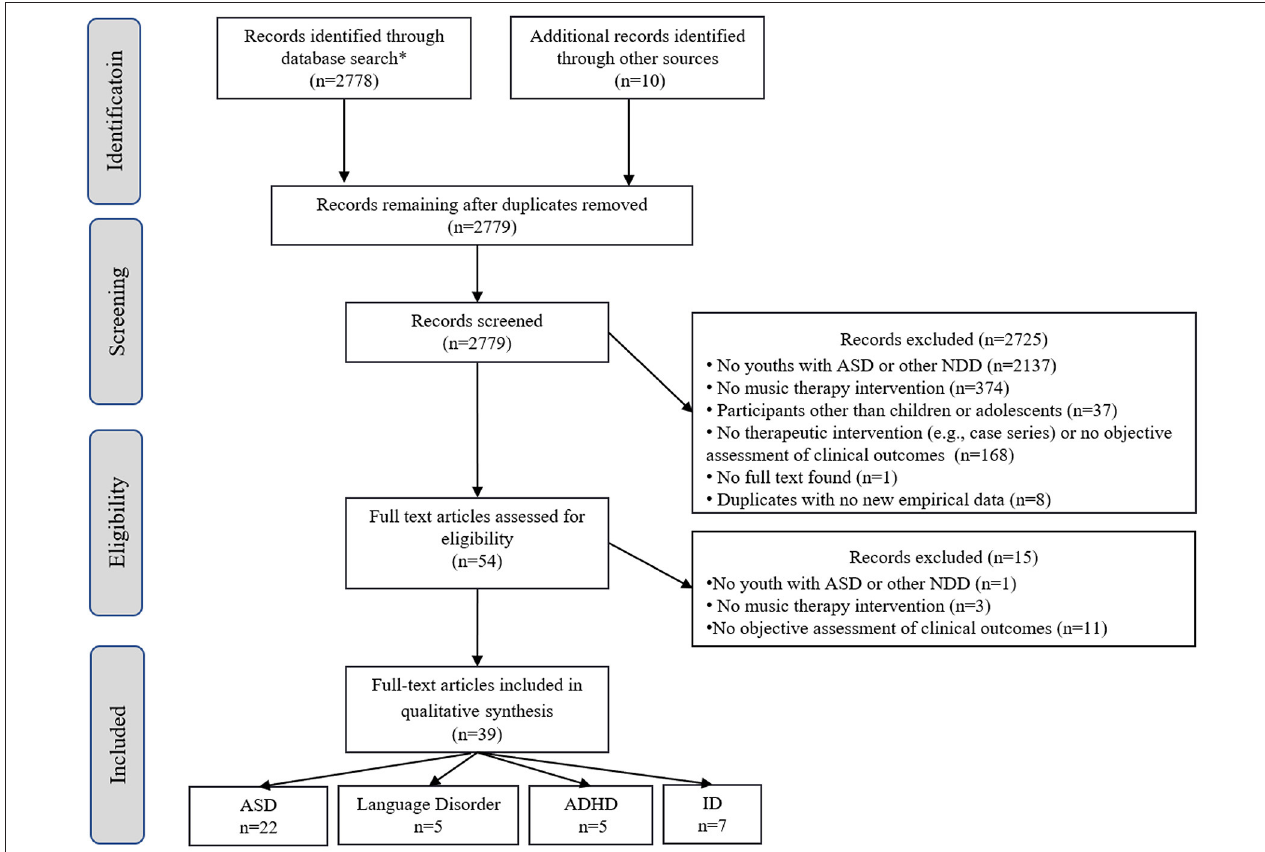
FIGURE 1 | Flowchart of the